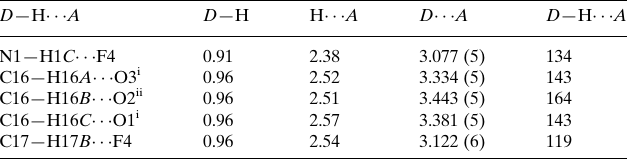
Hydrogen-bond geometry (A˚ , (cid:4)